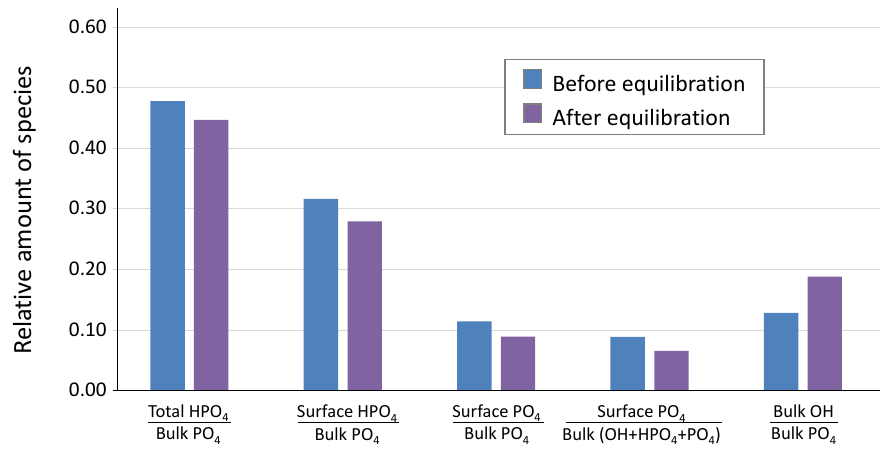
Figure 6. Evolution of the hydrated layer composition of sample hap-1d upon equilibration with Na3PO4 · 12H2O pH 11 (followed by final washing with pure deionized water). Data from FTIR spectral decomposition of the ν lib OH- ν 4 PO 4 domain. The uncertainty on each value is evaluated to 0.03. Several ratios are shown involving apatitic (bulk) and non-apatitic (surface) ionic